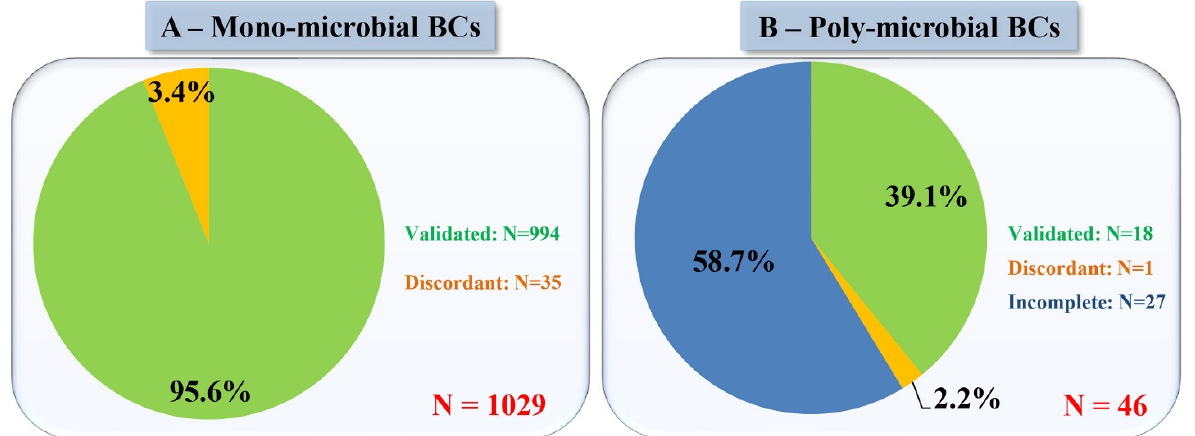
Figure 5. SEM identification results compared to those of MALDI-TOF/MS as a reference method in ( A ) mono-microbial blood cultures and ( B ) poly-microbial blood cultures. Validated: same identification results; Discordant: different identification results; Incomplete: Routine methods showed more microbes than did SEM.